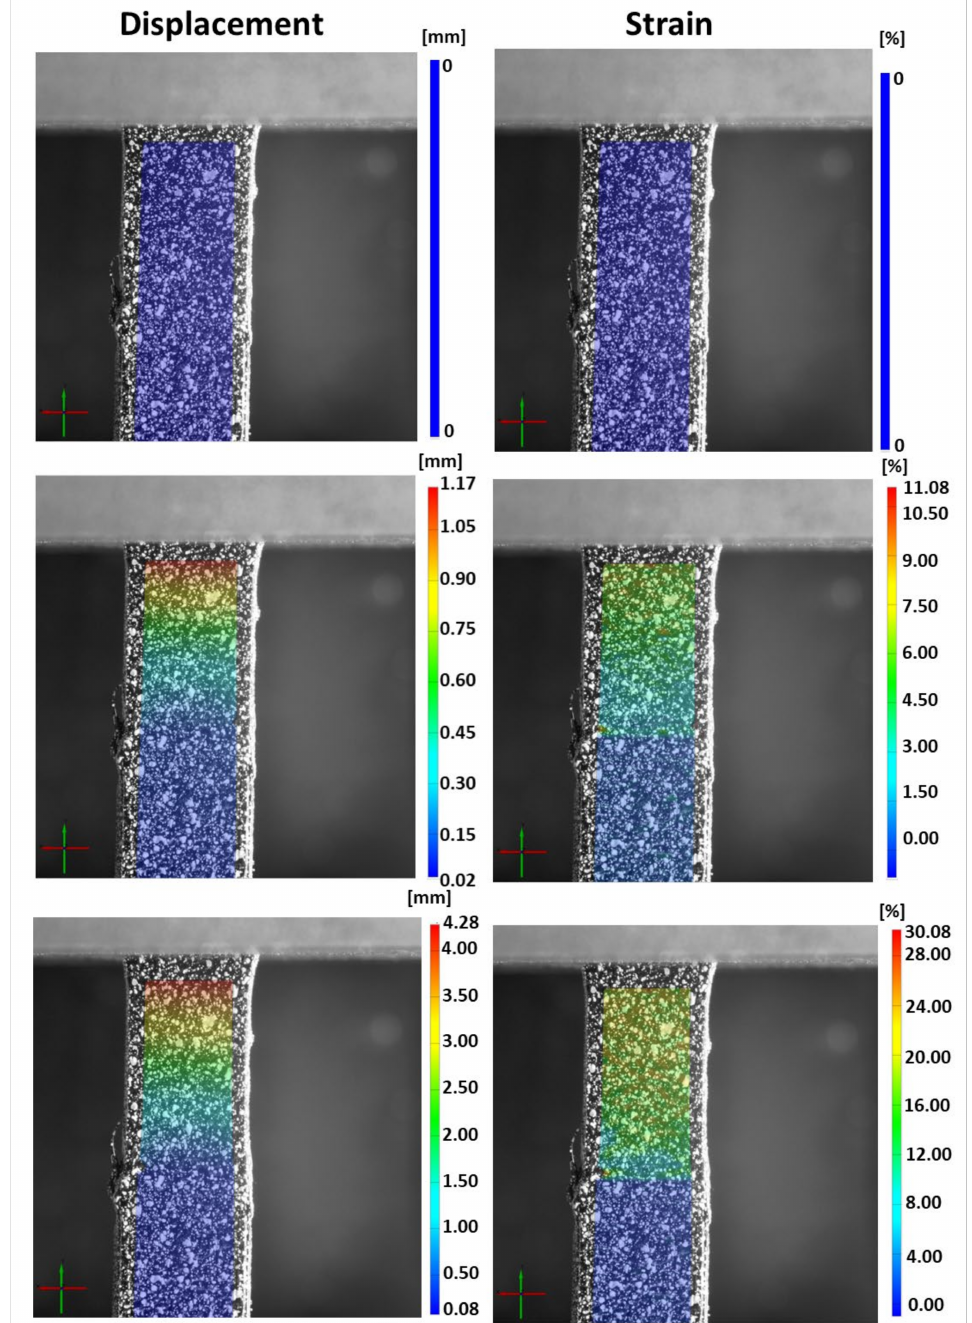
Figure 4. DIC measurements (strains and displacements) for of a sample with a bioinspired interface at t = 0, 55, and 135